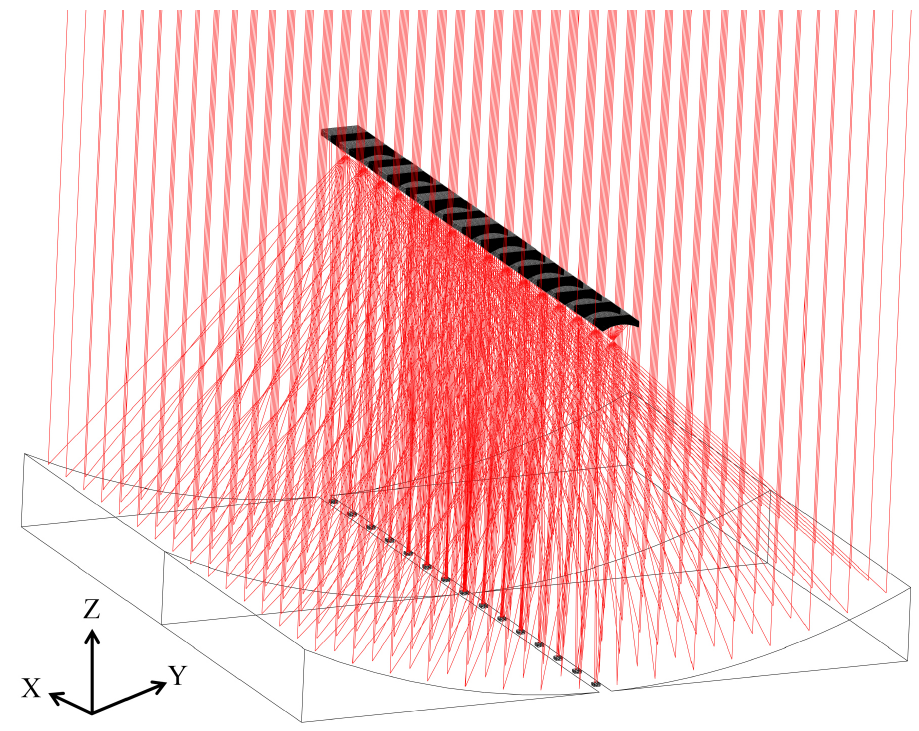
Energies 2023 , 16 , x FOR PEER REVIEW Figure 7. Illustrating non-sequential raytracing of the CPV system. Figure 7. Illustrating non-sequential raytracing of the CPV system.